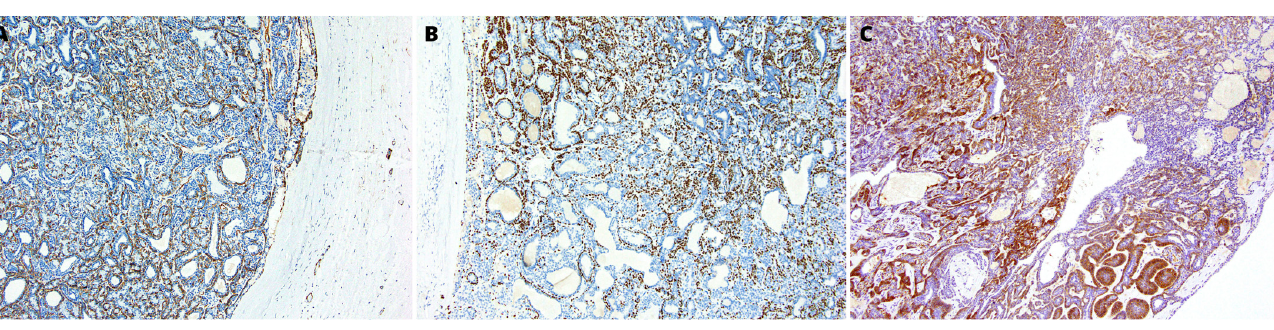
Figure 2. ( A ) The tumor mass surrounded the glandular structures of the salivary gland with positive staining for cytokeratin 19 (CK19). Obj. magnification 200× ( B ) The immunohistochemical profile of the tumor characterized positive staining for keratins AE1:AE3 and ( C ) S-100 protein. Obj. magnification 200×.